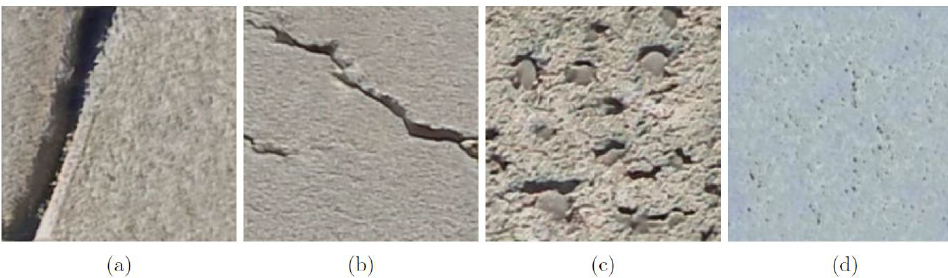
Figure 4. Synthetic images produced by the generator of the FS-GAN: ( a ) construction joint, ( b ) cracks, ( c ) pitting, and ( d ) undamaged.